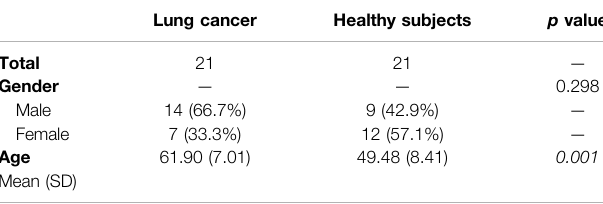
TABLE 5 | Basic clinical characteristics of the veri fi ed subjects. Lung cancer Healthy subjects